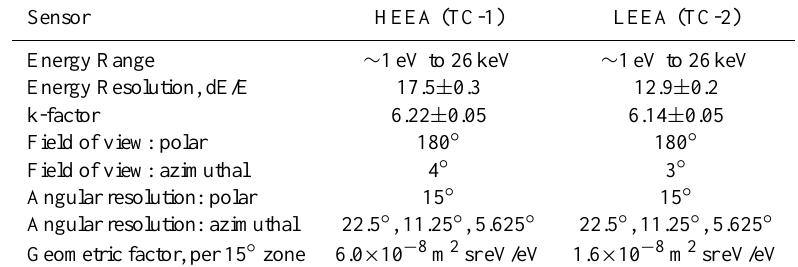
Table 2. Summary of sensor characteristics. Note that azimuthal resolution depends on sweep mode (see also Table 3).